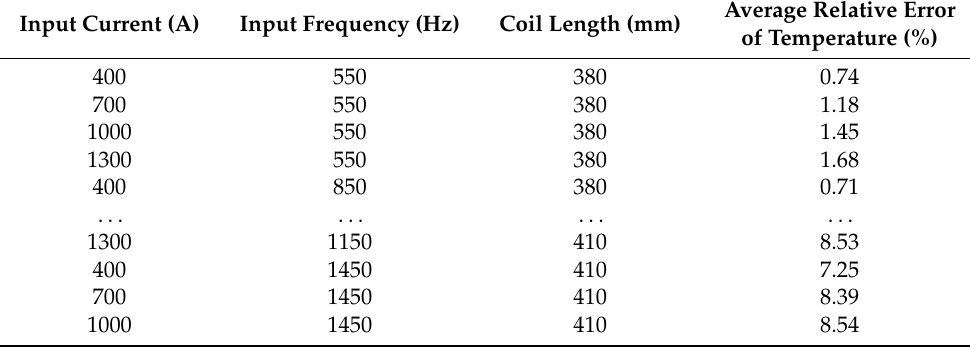
Table 2. Training samples.